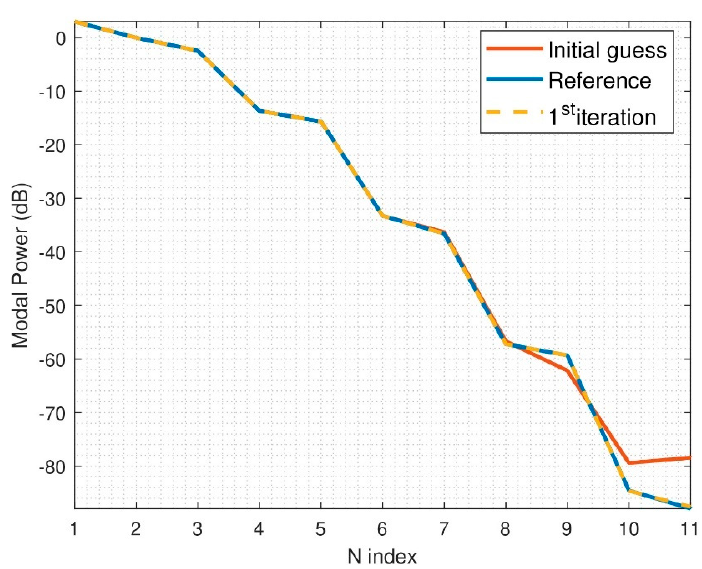
Figure 6. N ‐ power spectrum of reconstructed field, r 0 = 4 λ , d = λ , 2 arch positions. Figure 6. N-power spectrum of reconstructed field, r 0 = 4 λ , d = λ , 2 arch